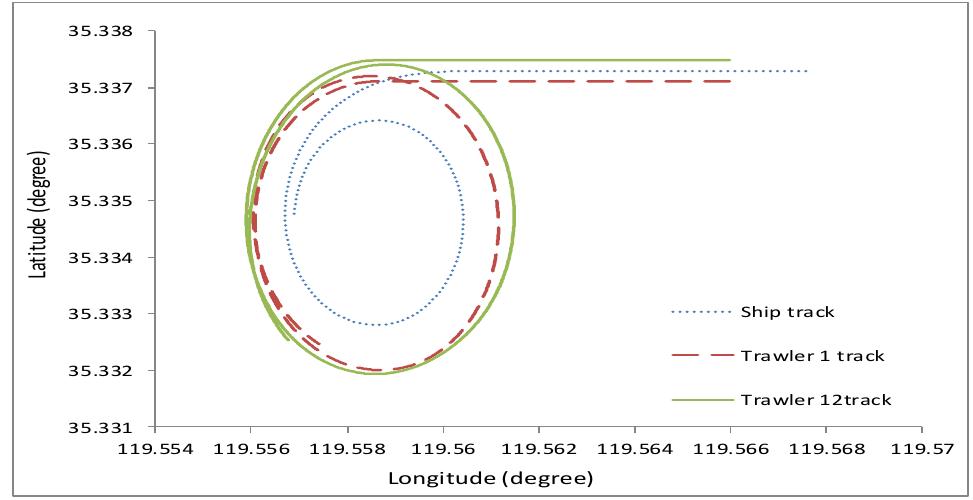
Figure 8. Rotation track of towing system.